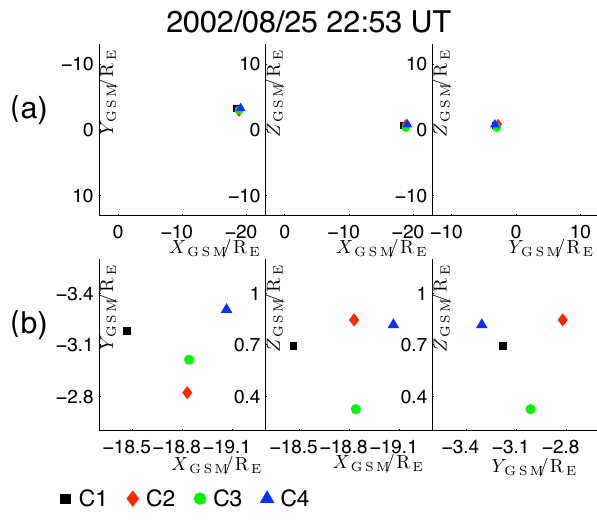
Fig. 1. (a) Position of the Cluster satellites given in GSM coordi- nates. (b) A magnified version of (a) showing the spacecraft tetra- hedron